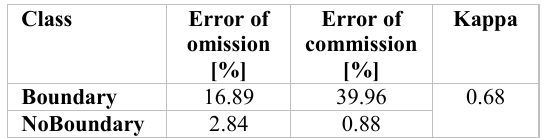
Table 3. Accuracy Assessment for Example 1.